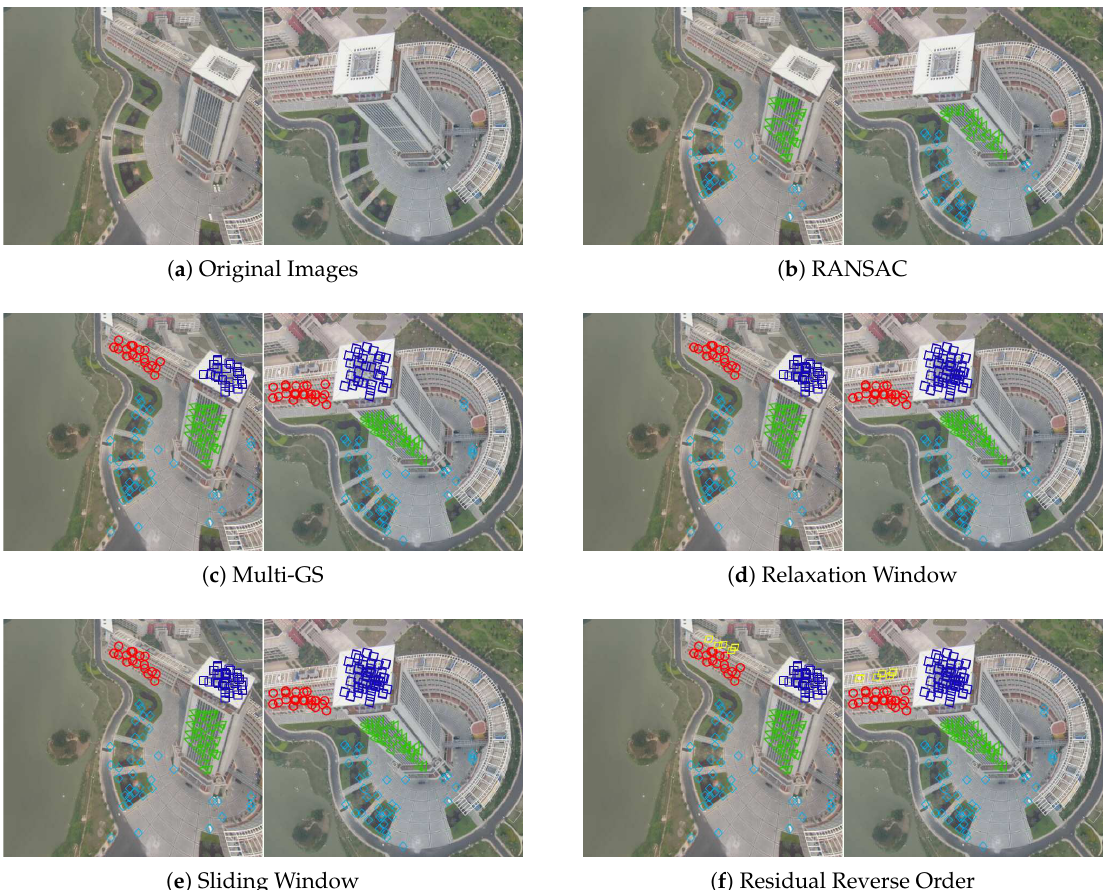
Figure 6. The five-homographic matrices extracted from HQU , where green triangles, blue squares, red circles, indigo diamonds, and yellow parallelograms represent the extracted inliers (correct matched features) that located on the side of high rise building, the roof of high rise building, the side of low rise building, the ground, and the roof of low rise building,